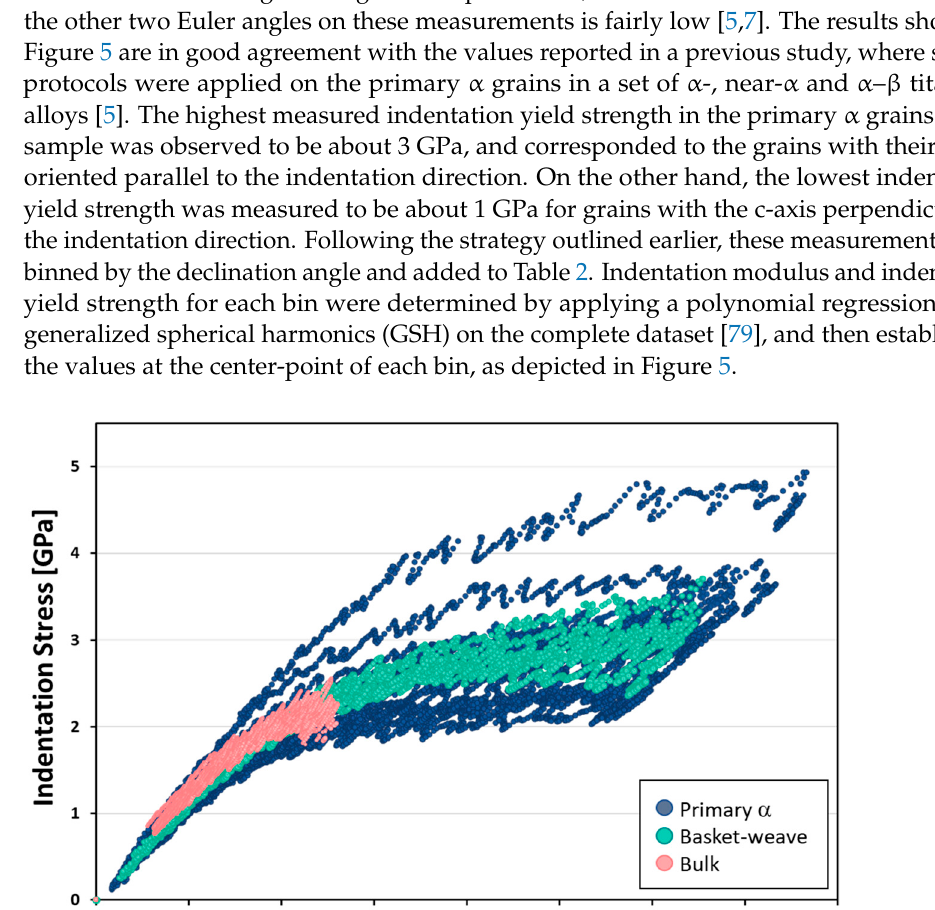
Figure 5. Results from the spherical indentations performed on the primary a grains, plotted as a function of the declination angle ( Φ ). Experimental results are shown as blue circles, and the values estimated from regression analysis at the mid points of each bin are depicted as yellow diamonds.